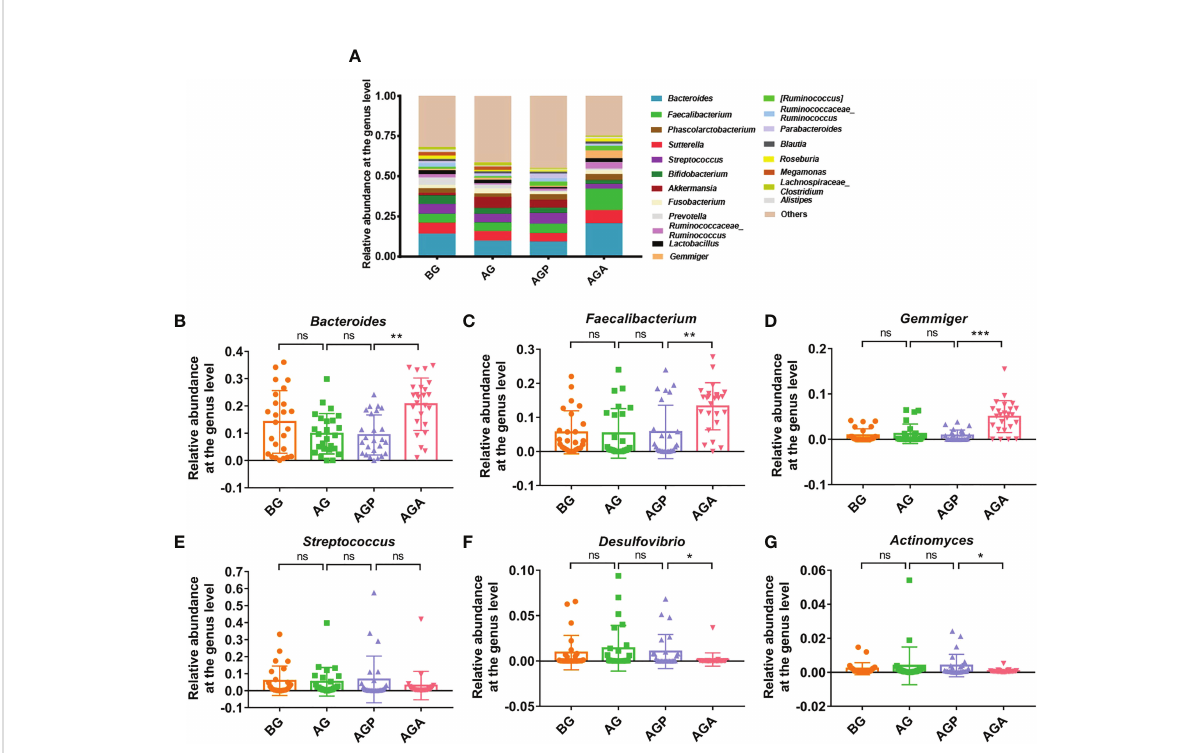
FIGURE 6 C butyricum altered gut microbial Composition of Patients with gastric cancer after Gastrectomy at genus level. (A) the relative abundance of intestinal microbiota at the genus level; (B) Bacteroides ; (C) Faecalibacterium ; (D) Gemmiger ; (E) Streptococcus ; (F) Desulfovibrio ; (G) Actinomyces . BG, gastric cancer patients before gastrectomy (n=25); AG, gastric cancer patients after gastrectomy (n=25); AGP, gastric cancer patients and treatment with the placebo after gastrectomy (n=45); AGA, gastric cancer patients and treatment with the C butyricum after gastrectomy (n=47). Data are presented as means ± SD. ns, no signi fi cance, P > 0.05, * P < 0.05, ** P < 0.01, *** P <